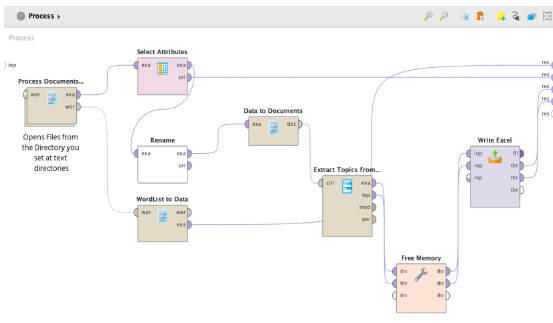
Figure 3. Topic Modeling Process on